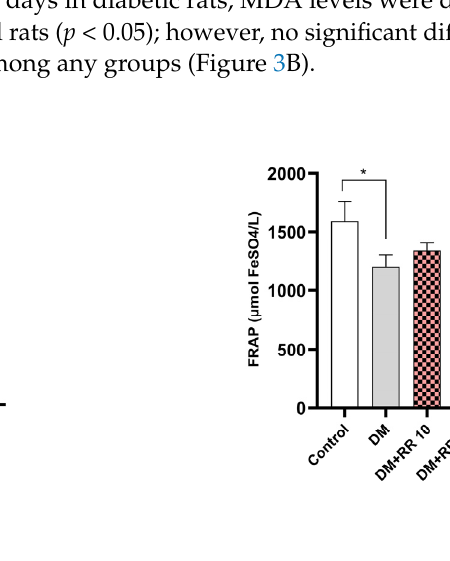
Figure 2 . Effects of various doses of RR and BR on triglyceride ( A ) and cholesterol ( B ) levels in STZ - induced diabetic rats . * P < 0 . 05 and ** P < 0 . 01, diabetic control group vs . healthy control group; # P < 0 . 05, treated group vs . diabetic control . Values represent mean ± S . E . M . (n = 8) .